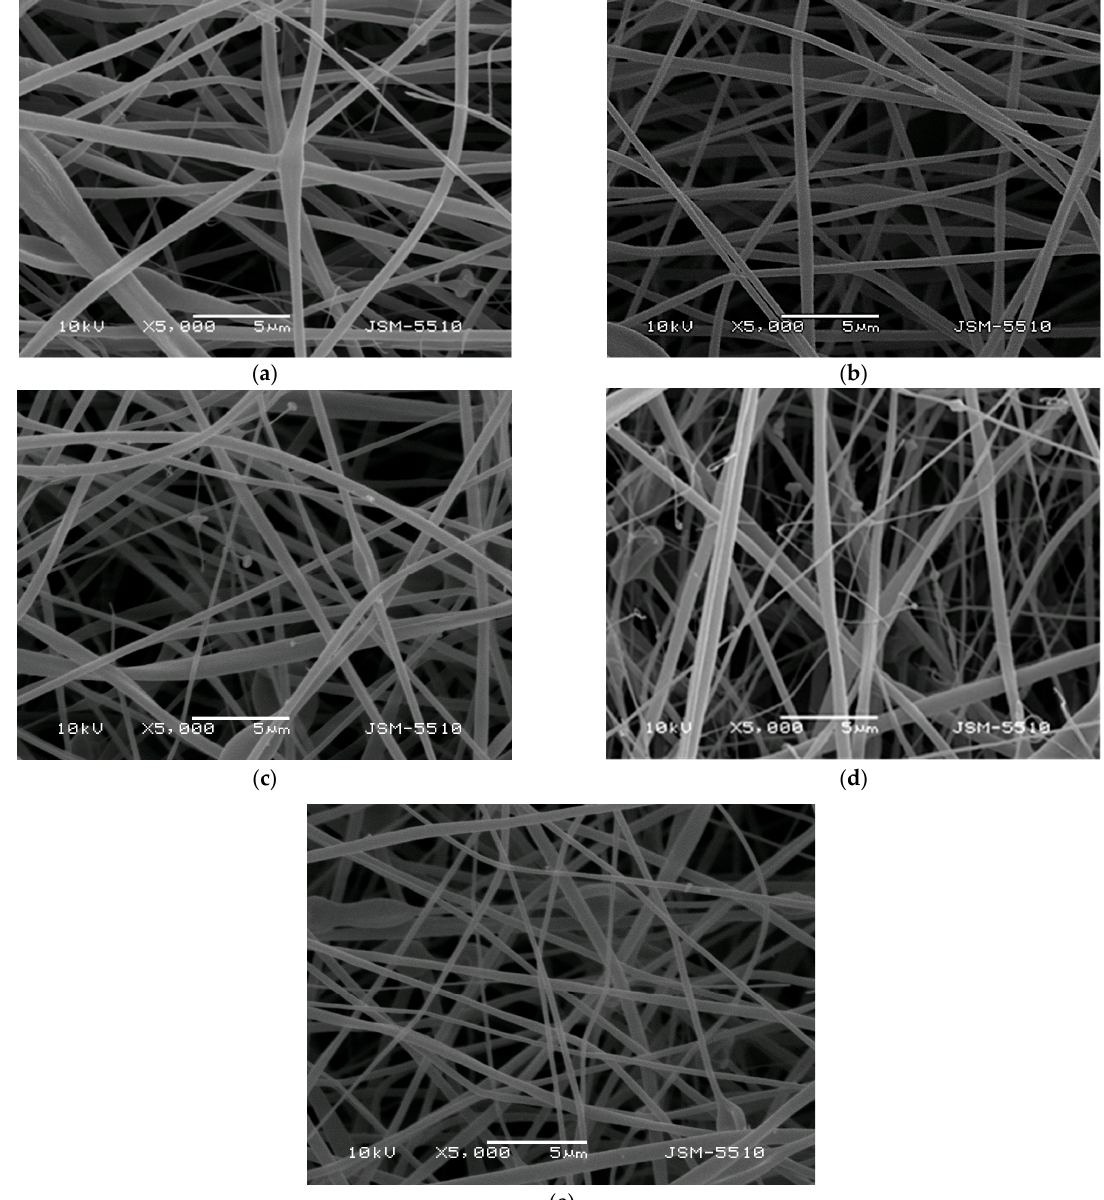
Figure 1. SEM images of the fibers based on: ( a ) СА /PEG, ( b ) СА /PEG/QUE, ( c ) СА /PEG/RUT, ( d ) СА /PEG/QUE/RUT, and ( e ) CA/PEG/QUE+CA/PEG/RUT.